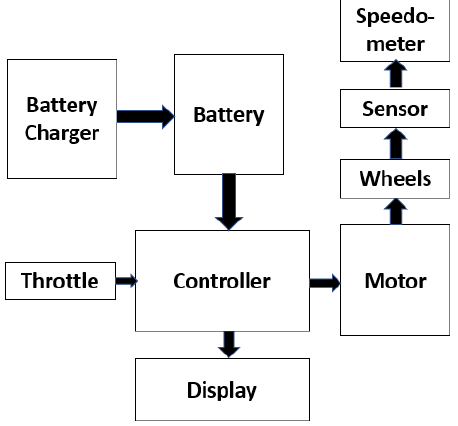
Fig.1: Block Diagram Fig.1 shows the Functional Block diagram of